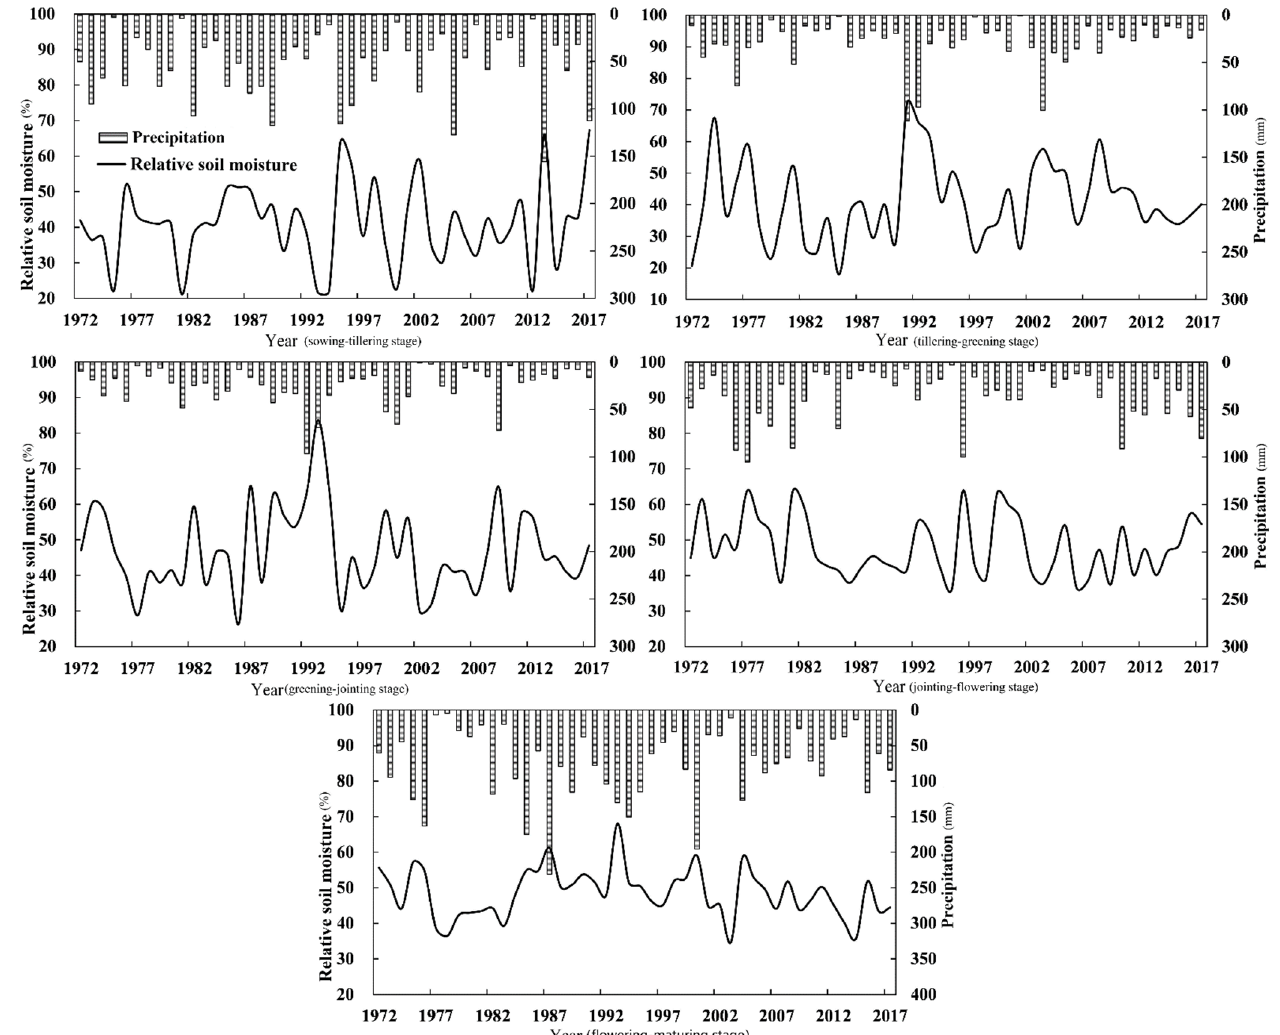
Figure 5. Change in annual precipitation and average relative humidity in winter wheat.